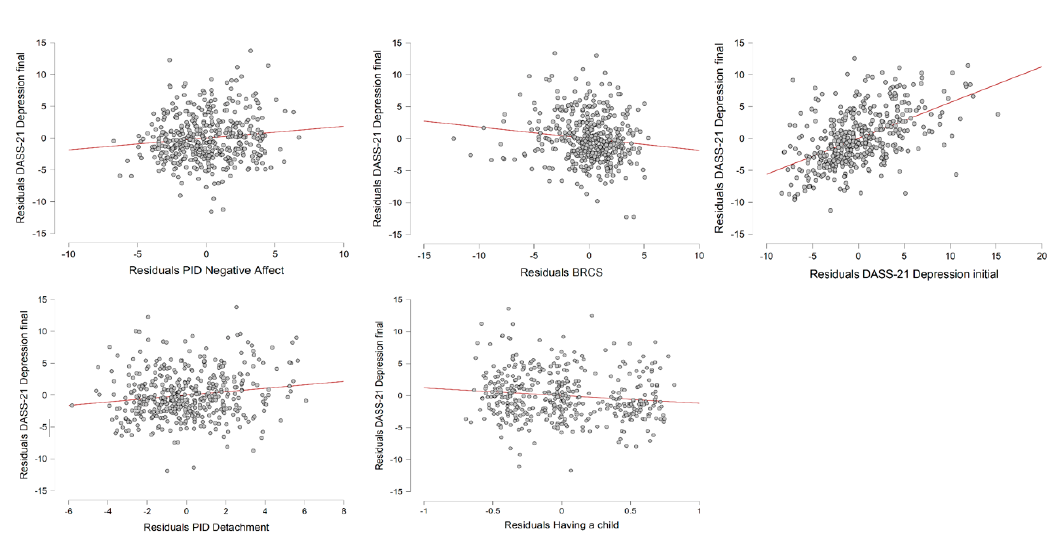
Figure 2. Partial regression plots representing the relationship between the DASS-21 Depression subscale score during the final period of the lockdown and the independent variables that accounted for a significant proportion of the variance according to the linear regression analysis. Table 4. Multiple Linear Regression Model Predicting the DASS-21 Stress Subscale Score During the Final Period of the Lockdown.